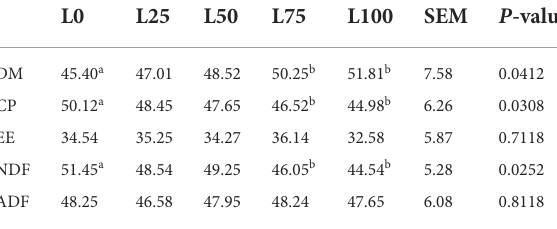
TABLE 3 Percentage of disappearance after 48-h in vitro digestion in different substitution treatments of lucerne with lemon pomace by-product after 60 days of